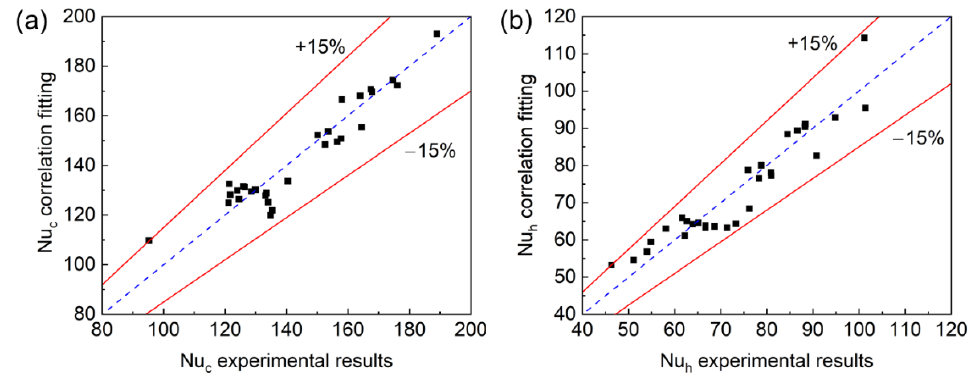
Figure 6. The difference between the correlations and the experimental results on ( a ) the cold side